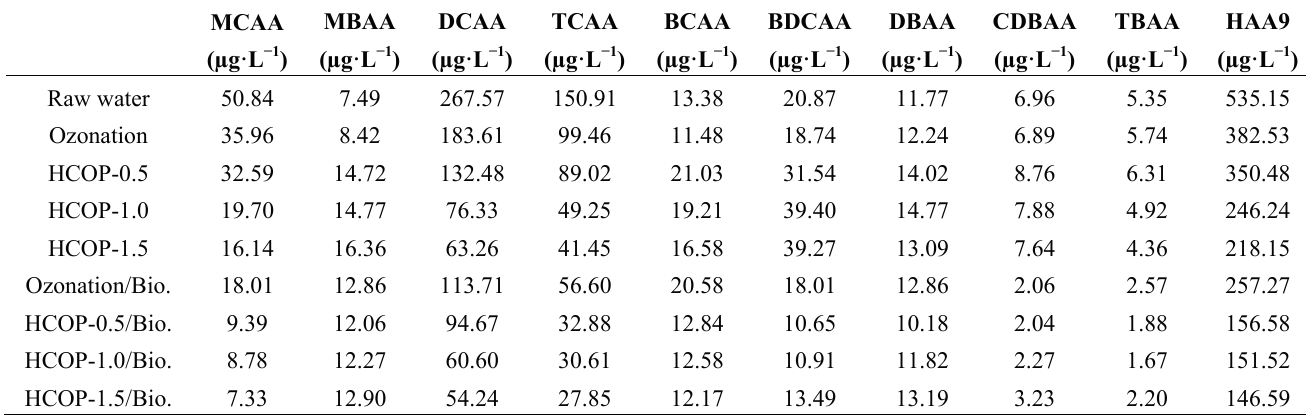
Table 5. The concentrations of individual HAA species under different experimental conditions.